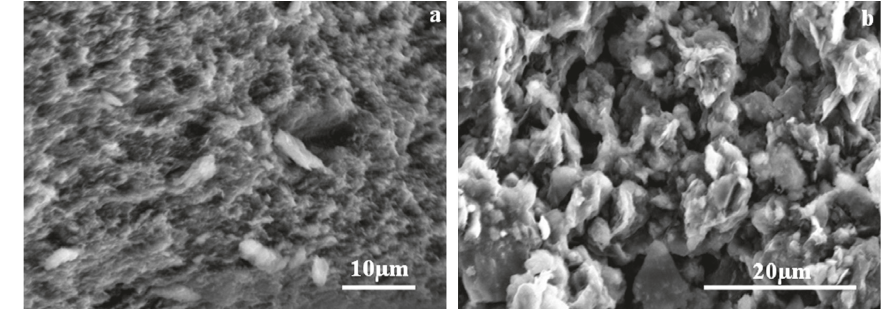
Figure 18: Scanning electron microscopy view of raw clay (a) and purified clay (b) after MG